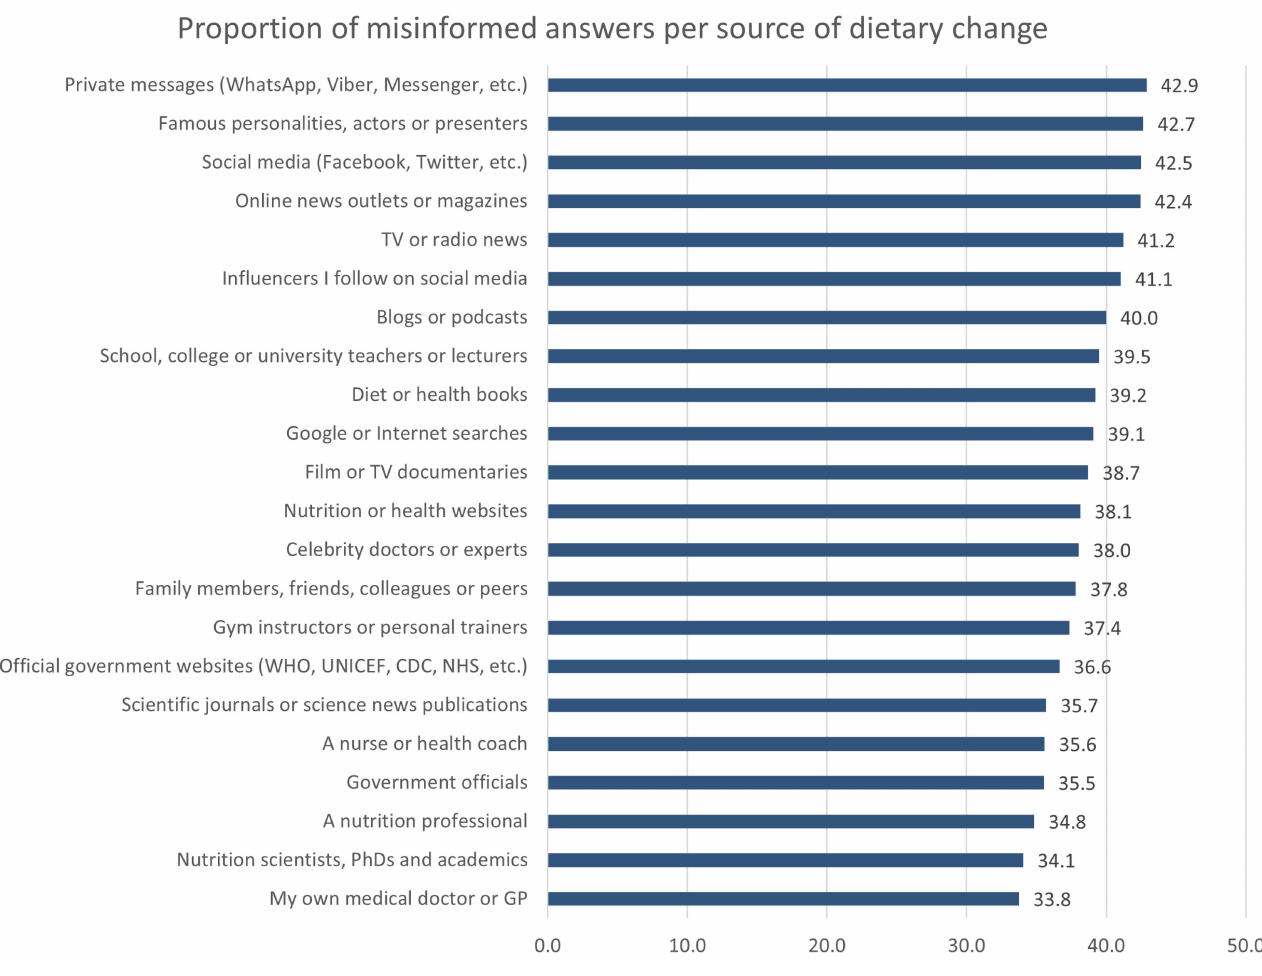
Figure 2. Proportion of COVID-19 nutrition misinformation held in relation to different information sources used for subsequent eating behavior